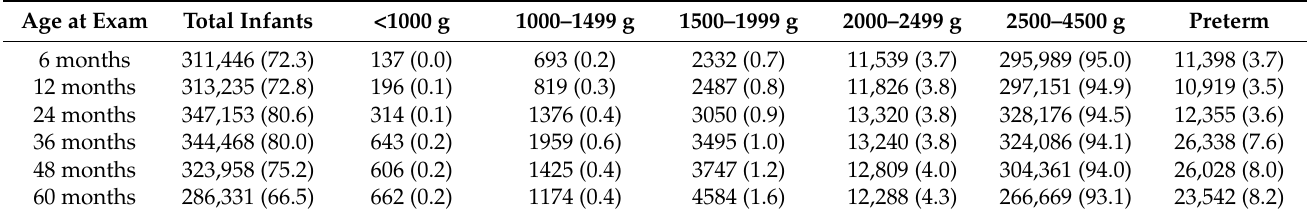
Table 1. The population characteristics at the health checkup according to birth-weight